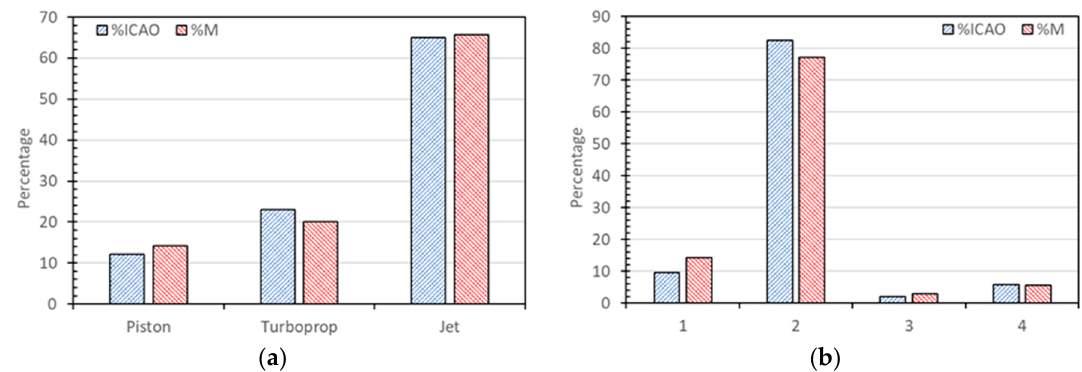
Figure 7. Distribution of aircraft engines for accidents with maintenance contributions: ( a ) the type of engine; ( b ) the number of engines.